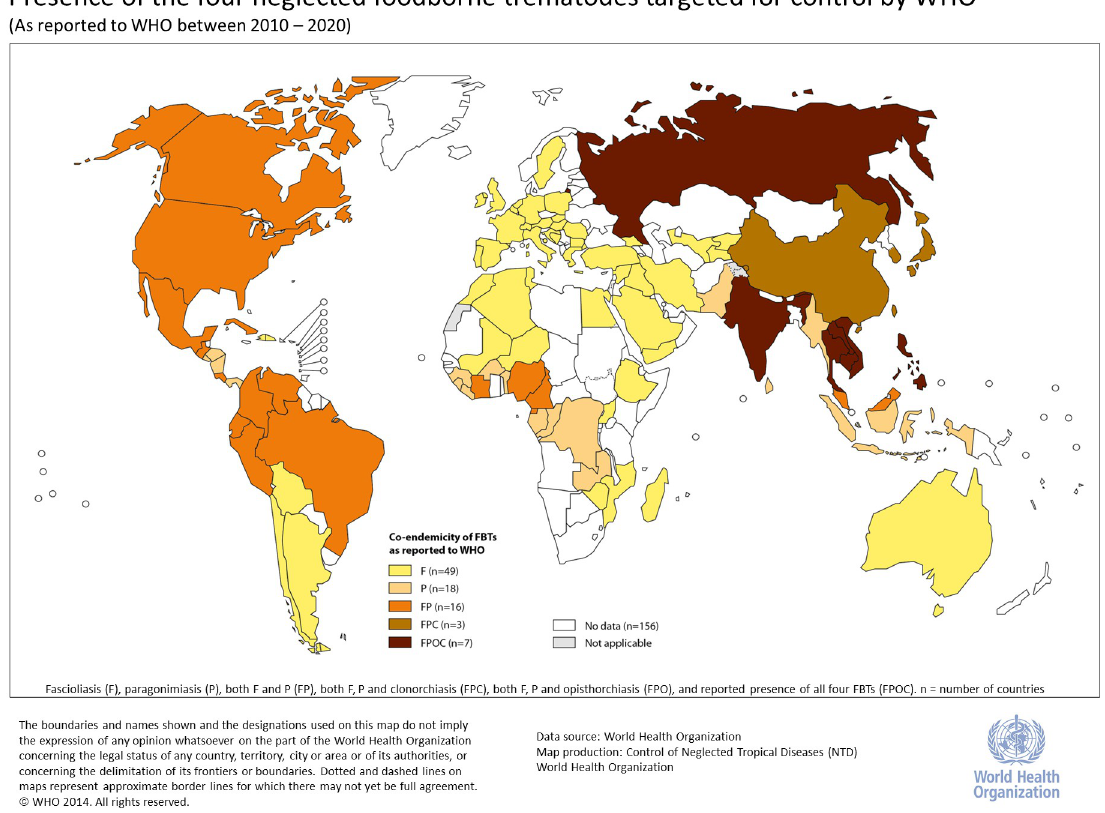
Fig 2. Map depicting the endemicity or co-endemicity of the 4 neglected FBTs as reported to the WHO between 2010 and 2019. The categories include fascioliasis (F); paragonimiasis (P); both F and P (FP); both F, P, and clonorchiasis (FPC); both F, P, and opisthorchiasis (FPO); and reported presence of all 4 FBTs (FPOC). The number of countries under each category is